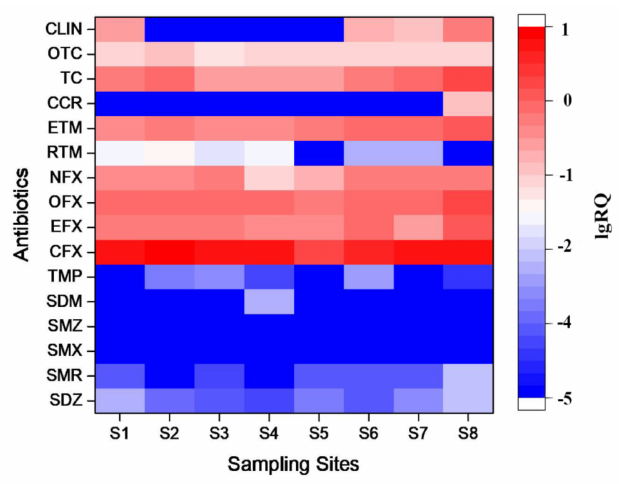
Figure 4. Ecological risk assessment of antibiotics in surface